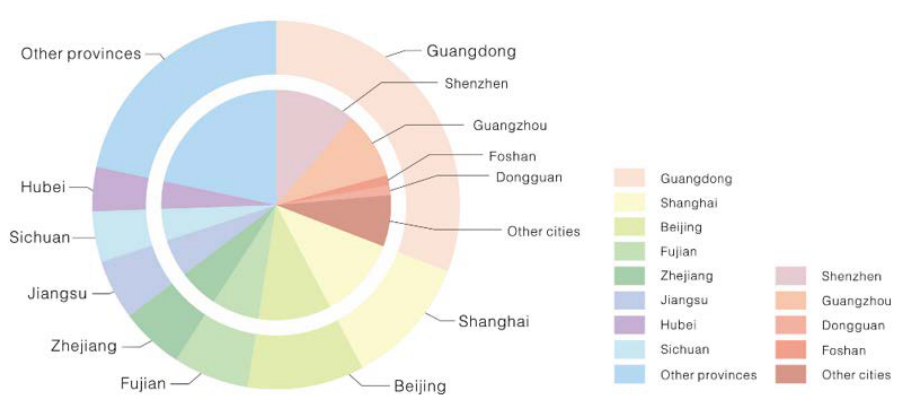
Figure 9. Proportions of visitor sources for all visitors.